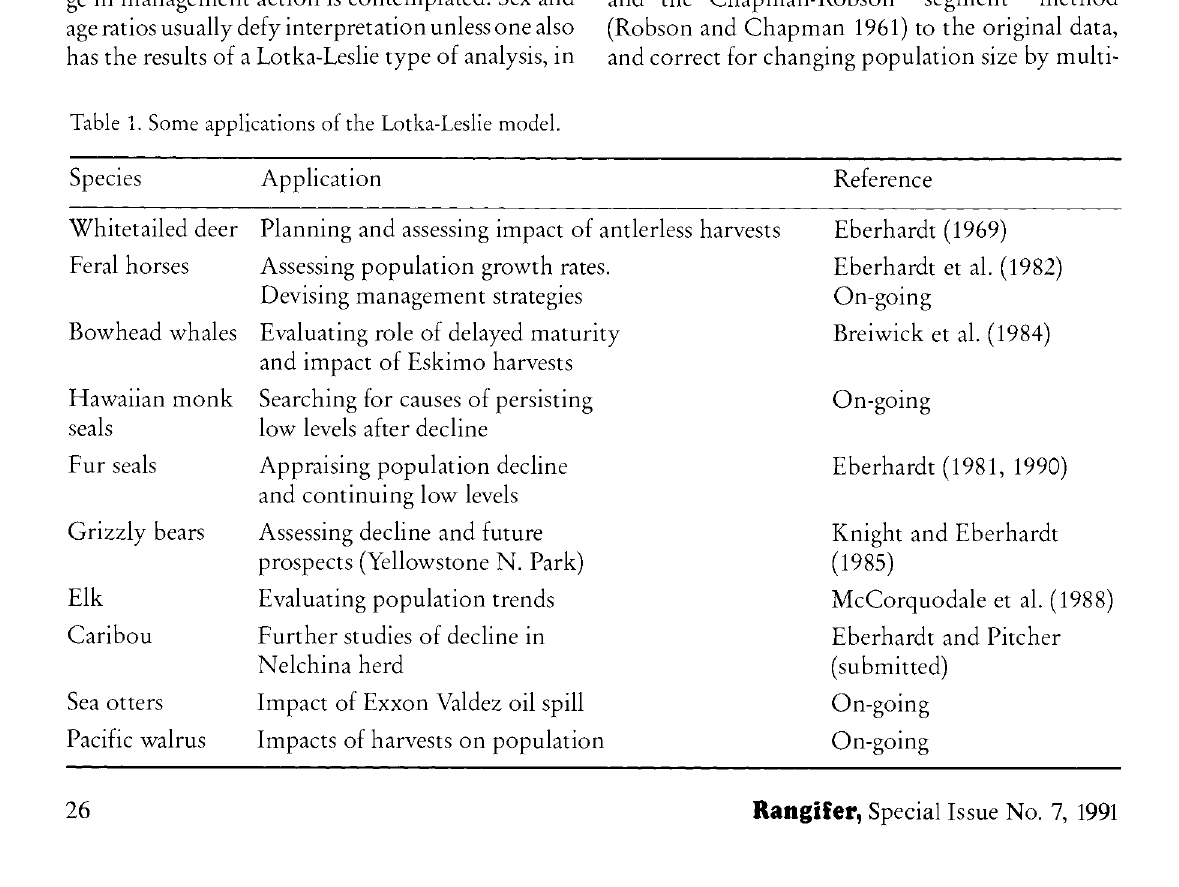
Table 1. Some applications of the Lotka-Leslie model. Species